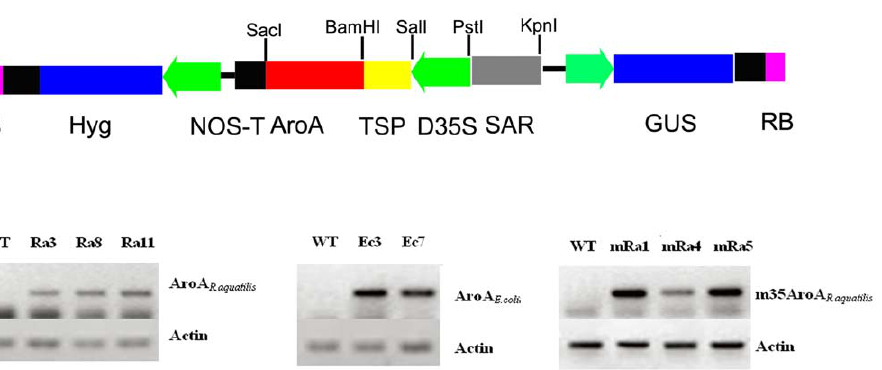
Figure 4. (A) Schematic diagram of the T-DNA region of the binary vectors used in this study. LB, left border; Hyg, hygromycin phosphotransferase gene; D35S, double cauliflower mosaic virus 35S promoter; TSP, tobacco transit peptide; AroA, EPSPS gene; NOS-T, nopaline synthase gene terminator; RB, right border. For the steady transmission of the aroA gene, scaffold attachment region (SAR) was fused upstream of the D35S promoter. (B) Evaluation of the glyphosate resistance of transgenic lines. (A) RT-PCR analysis of the transcripts of the AroA R.aquatilis , m35AroA R.aquatilis , and AroA E.coli genes in transgenic and nontransgenic tobacco lines. Normalized expression of the Actin gene was used as control. WT, nontransgenic tobacco; Ra3, Ra8, and Ra11, AroA R.aquatilis transgenic lines; Ec3 and Ec7, AroA E.coli transgenic lines; mRa1, mRa4, mRa5, m35AroA R.aquatilis transgenic lines.